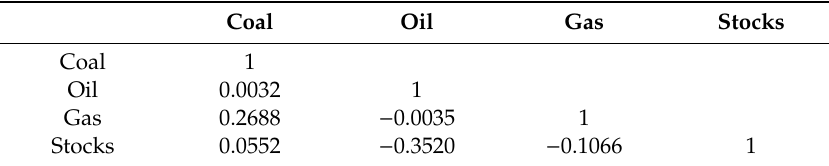
Table 7. Correlations for Australia.